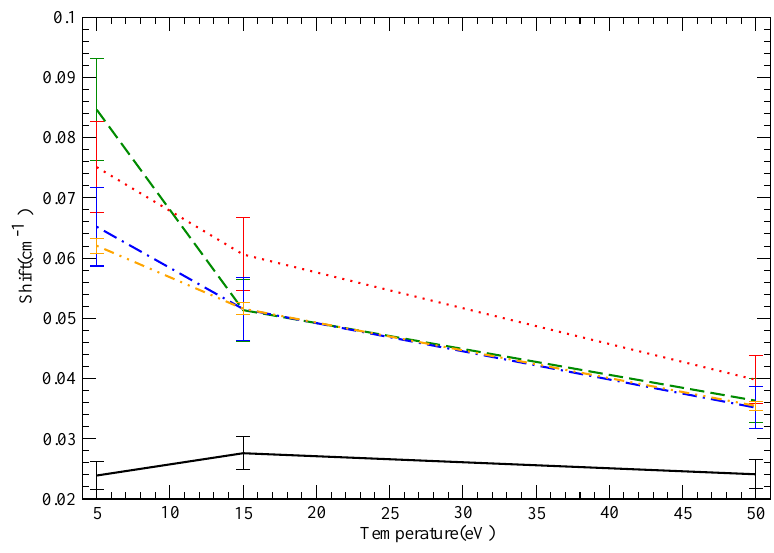
Figure 8. A comparison of hyperbolic and straight-line trajectories for the B III 2s-2p transition widths, as computed by SCP-hyperbolic (solid black), SCP-straight (dotted red), SimU-hyperbolic (dashed green), SimU-straight (dash-dotted blue) and Simulation (dash-double dotted